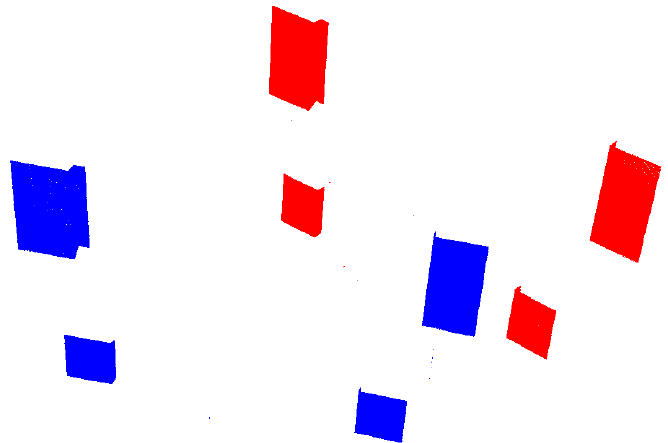
Figure 20. Target areas. The red part is Area1 and the blue part is Area2.